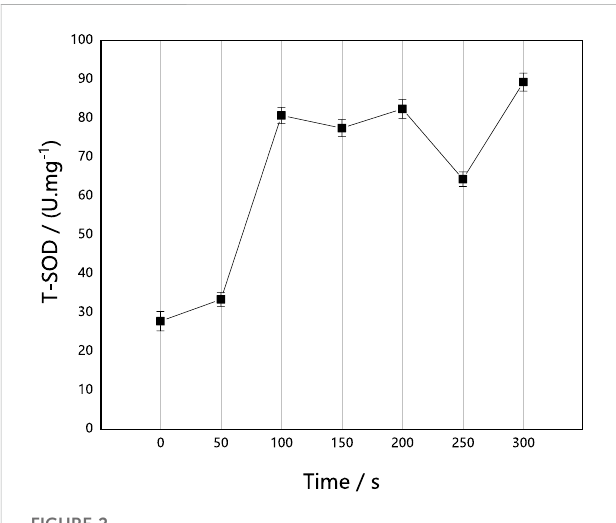
FIGURE 1 Effect of implantation time of ARTP on the survival rate of M. thermophila . Survival rate wasthe percentage ofthe number ofcolonies after implanted by ARTP to the none implanted. All experiments were carried out four times (biological duplicates and technical duplicates) and mean values presented with standard deviations.